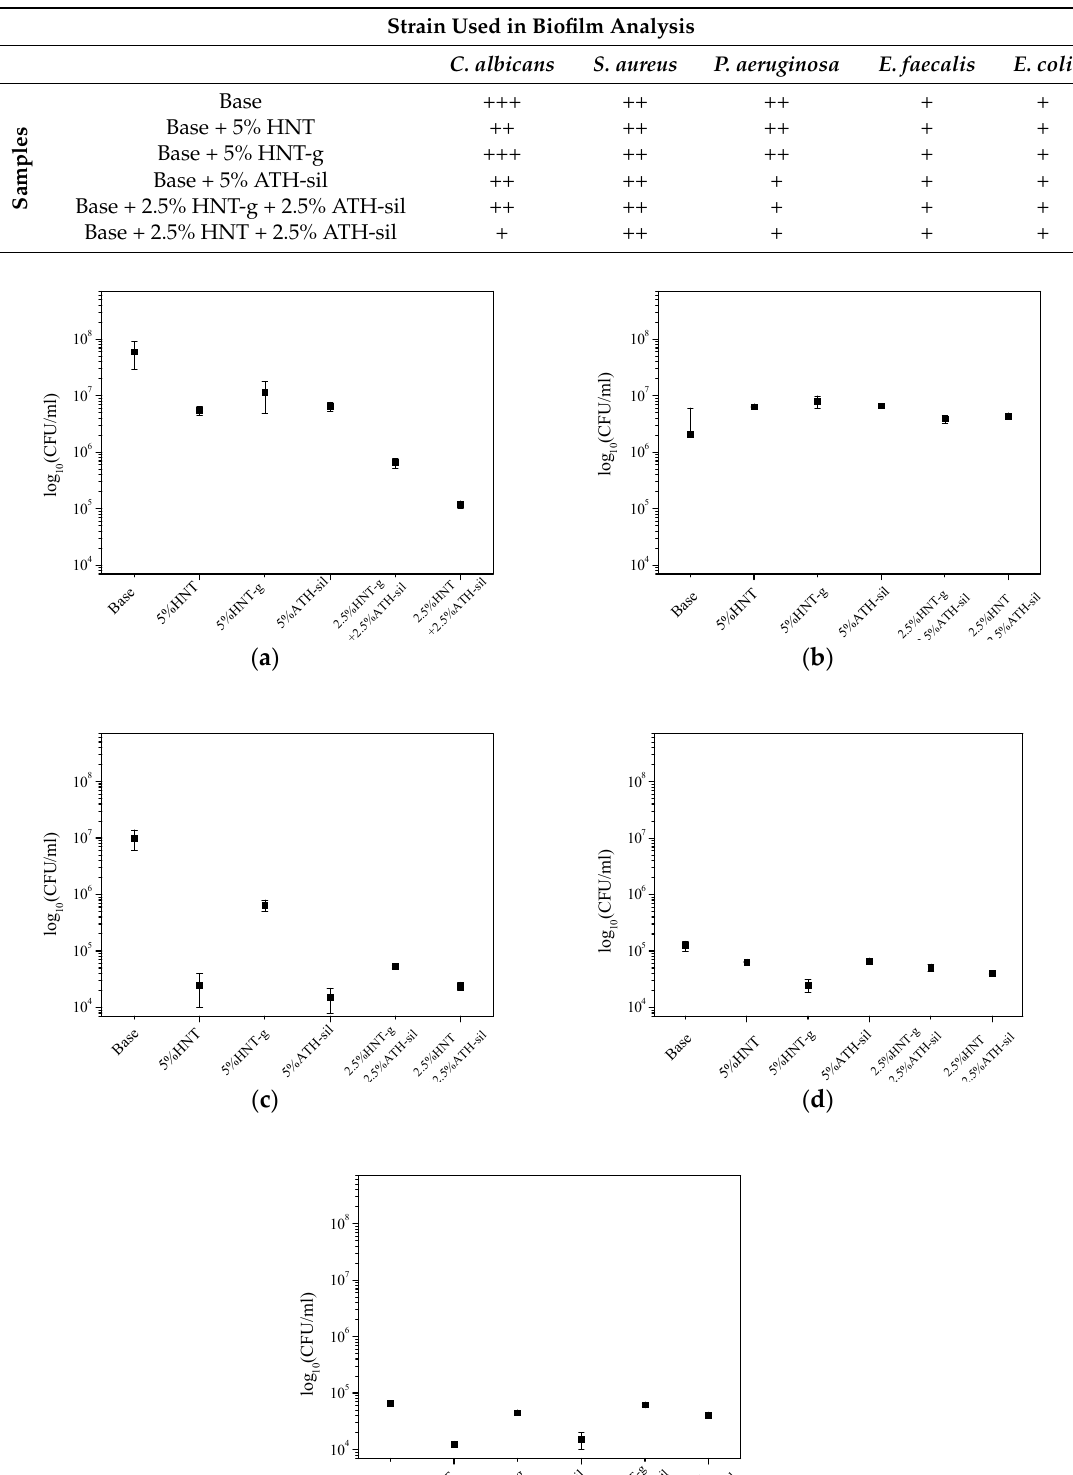
Table 4. Classification of biofilm formation for individual strains.